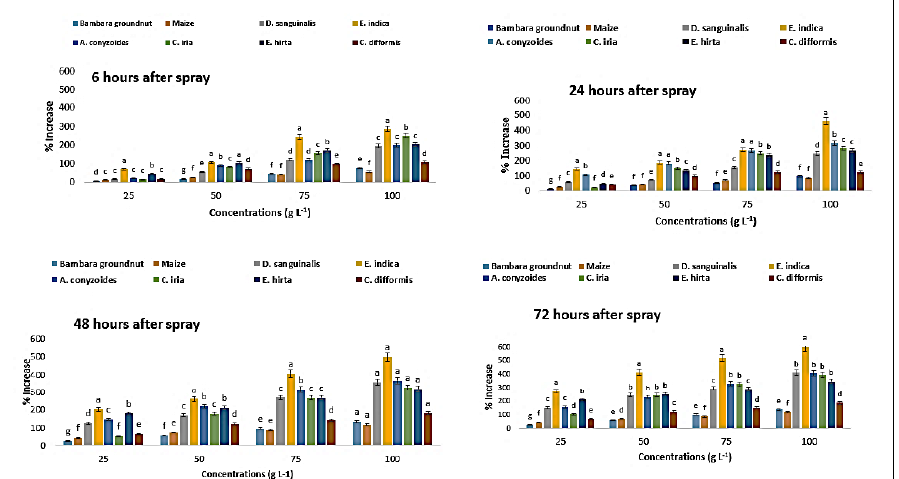
Figure 12. Increase (%) in MDA content in test crops and weeds treated with parthenium leaf methanol extract at different associated times. Values with the same letter among the tested crops and weeds are not significantly different at the same extract concentrations at p ≤ 0.005, determined by Turkey’s HSD.